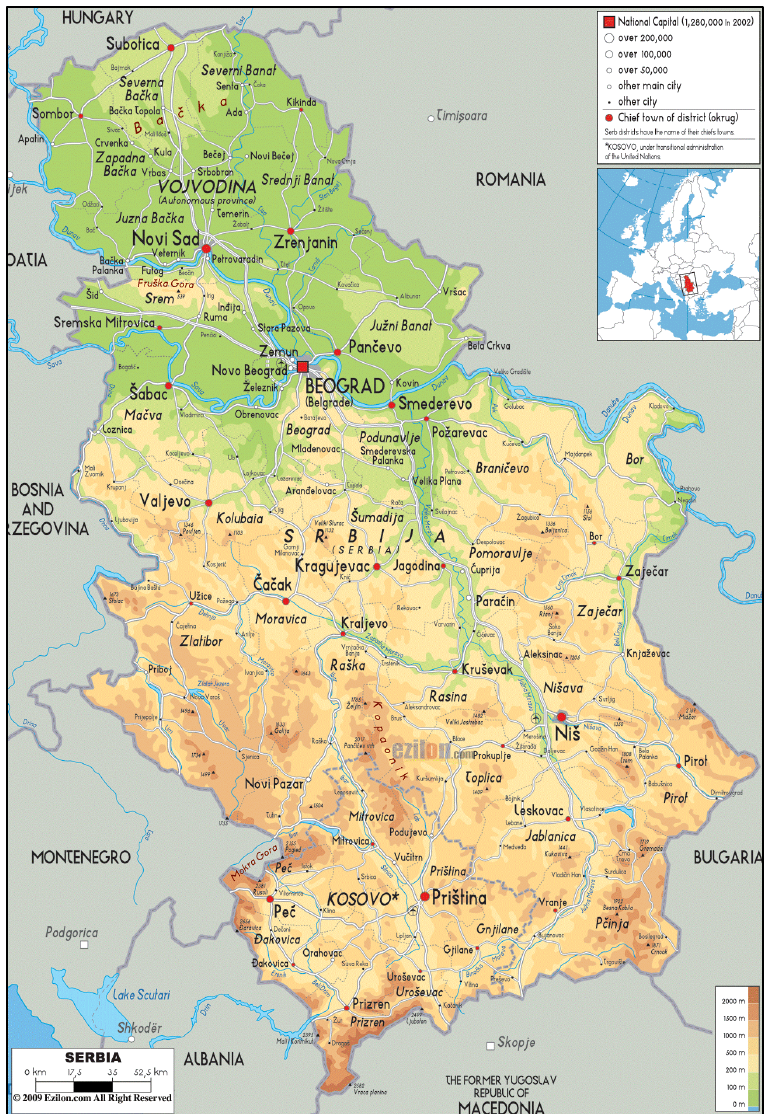
Figure 8. The physical map of Serbia showing major geographical features like elevations, mountain ranges, seas, lakes, plateaus, peninsulas, rivers, plains, landforms and other topographic features (Source: Ezilon Maps,